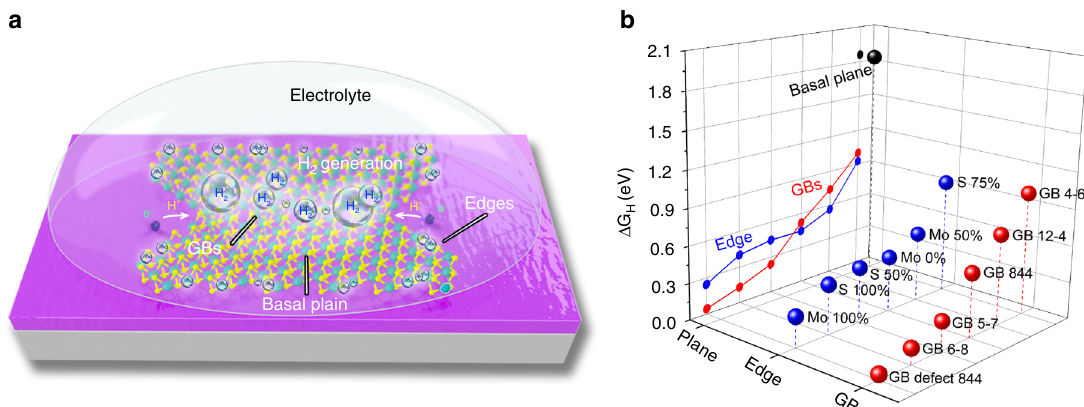
Fig. 4 Theoretical calculations of the catalytic sites in MoS 2 for HER. a Schematic of MoS 2 with an illustration of the main types of catalytically active sites for the hydrogen evolution reaction (HER) including: basal plane atomic sites, edges, and GBs. b corresponding Δ G H of various types of catalytically active sites in MoS 2 catalysts. Some types of GBs (e.g., 844, 6 – 8, and 5 – 7) show better electrocatalytic activity